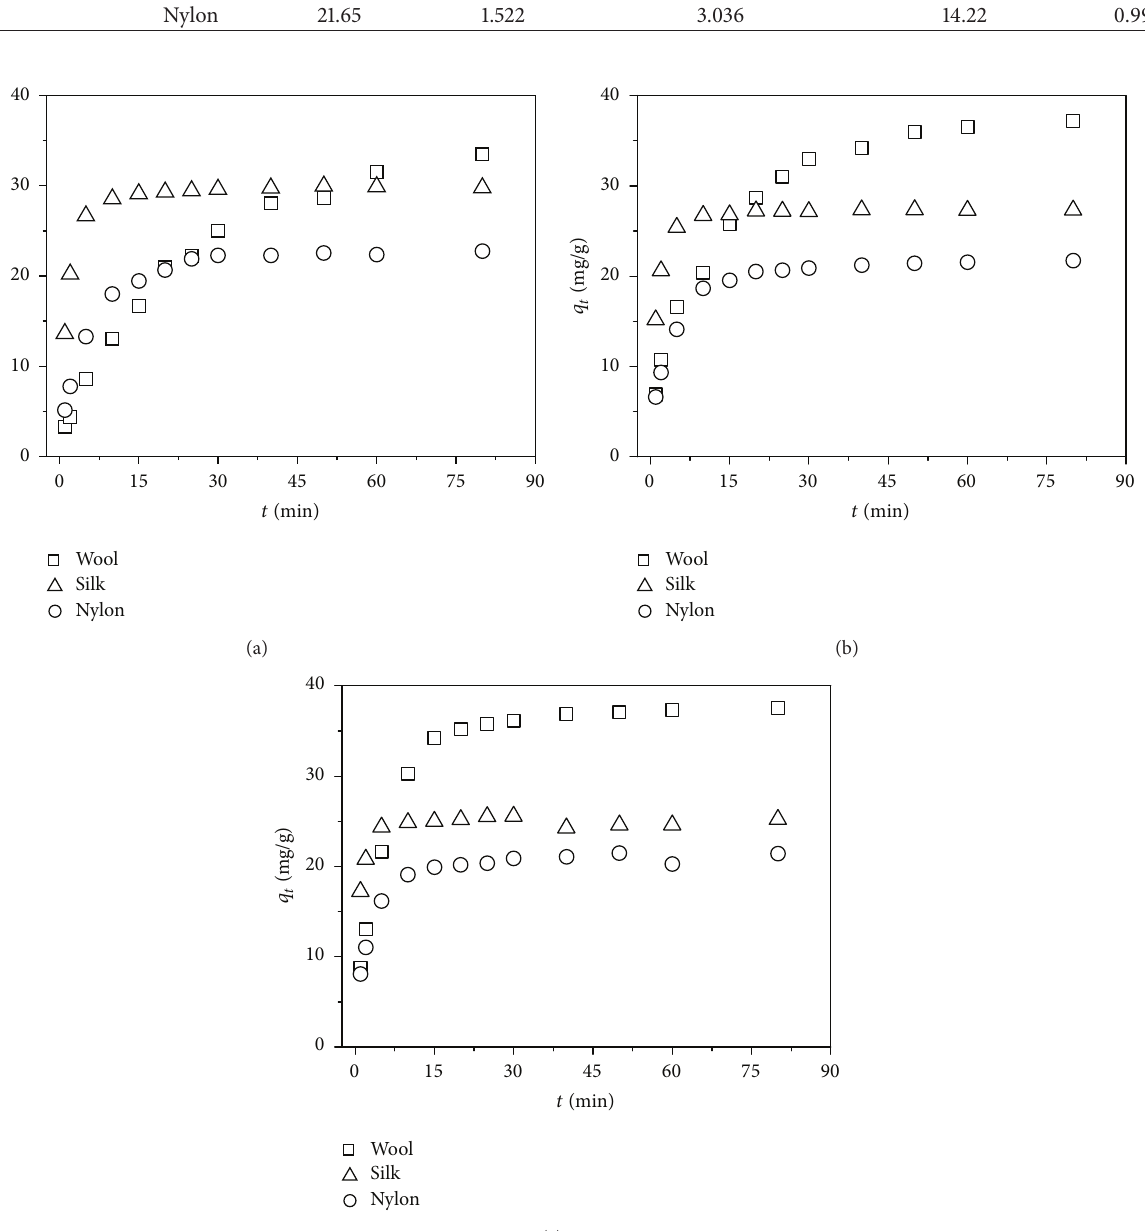
Figure 1: Adsorption rates of lac dyes for wool, silk, and nylon at 70 ∘ C (a), 80 ∘ C (b) and 90 ∘ C